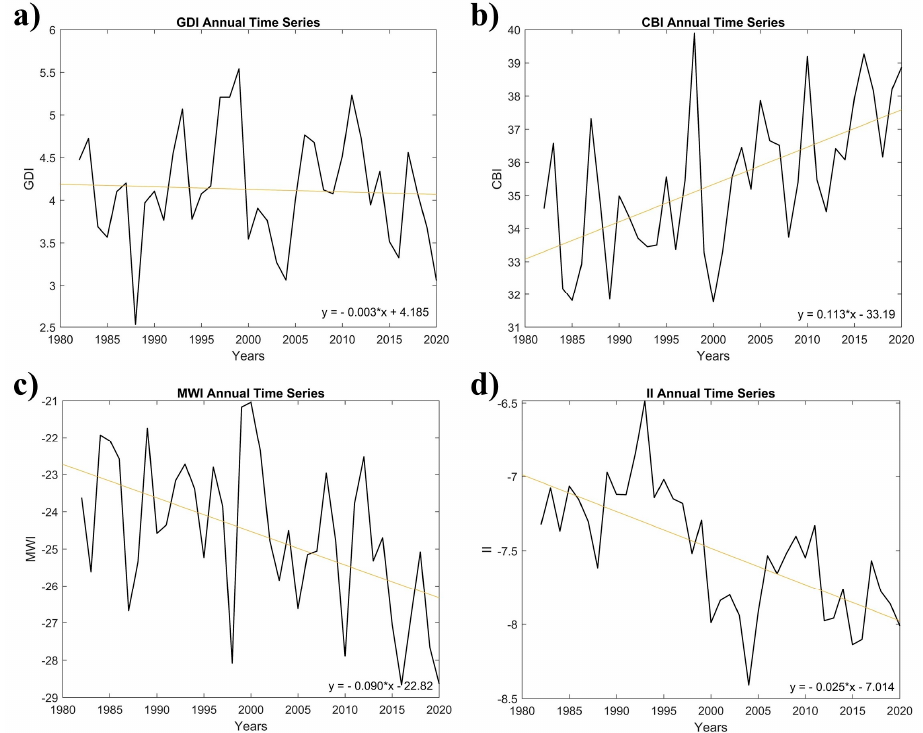
Figure 7. Summary of annual regional (spatial) averaged trends over 1982–2020 for ( a ) the Galvez- Davidson Index (GDI), ( b ) Column Buoyancy Index (CBI), ( c ) the Mid-level Warming Index (MWI), and ( d ) the Inversion Index